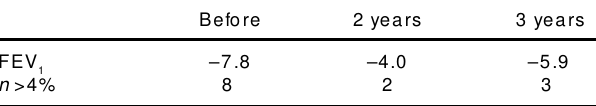
Table 3. Airway responsiveness before and after building renova- tion, expressed as change in forced expiratory volume in 1 s (FEV